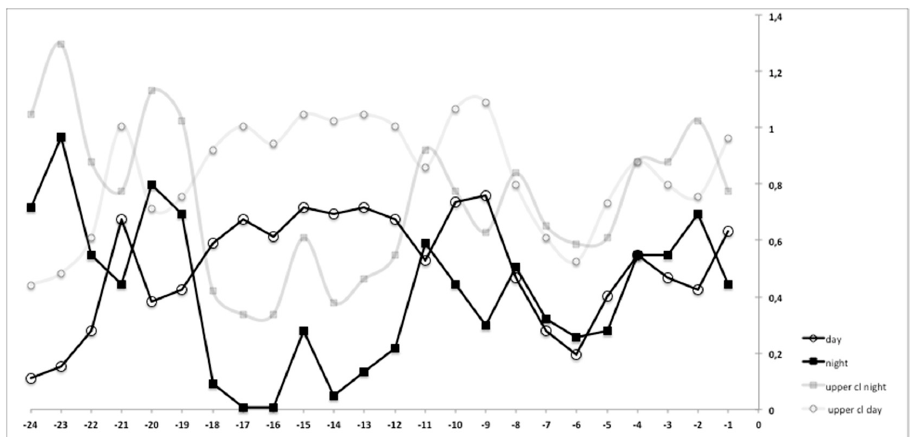
Figure 3. Least square means and upper confidence limits of lying behaviour for cows that calved at night and by day. On the x-axis: hour relative to delivery; on the y-axis: hourly proportion of records ( n /12).